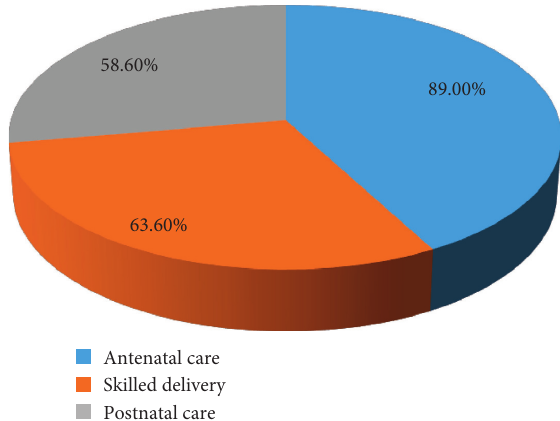
Figure 3: Practice of maternal health service utilization among women of reproductive age at West Shoa Zone, Ethiopia,